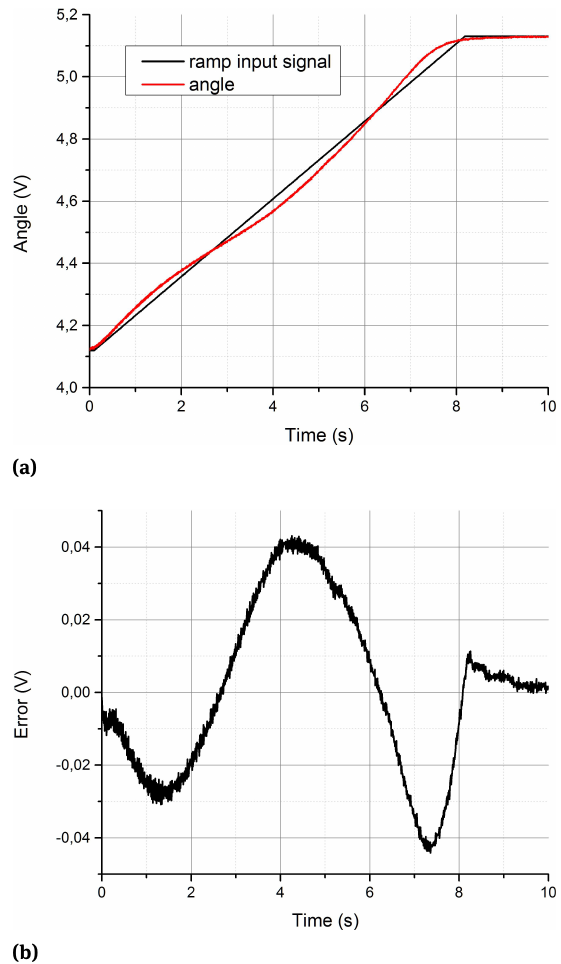
Figure 8: Experimental results: a) angle, b)